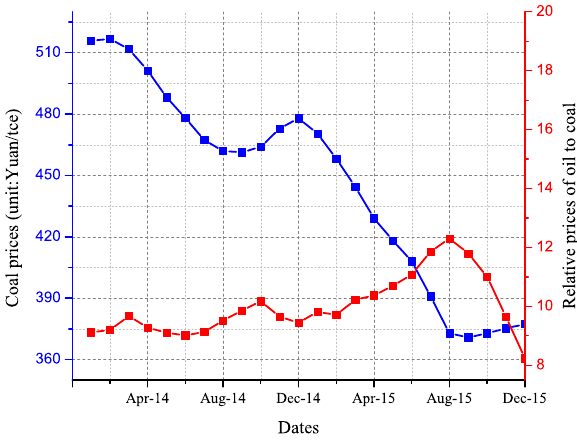
Figure 4. The three-dimensional graph of W 1 , P 1 , and α .